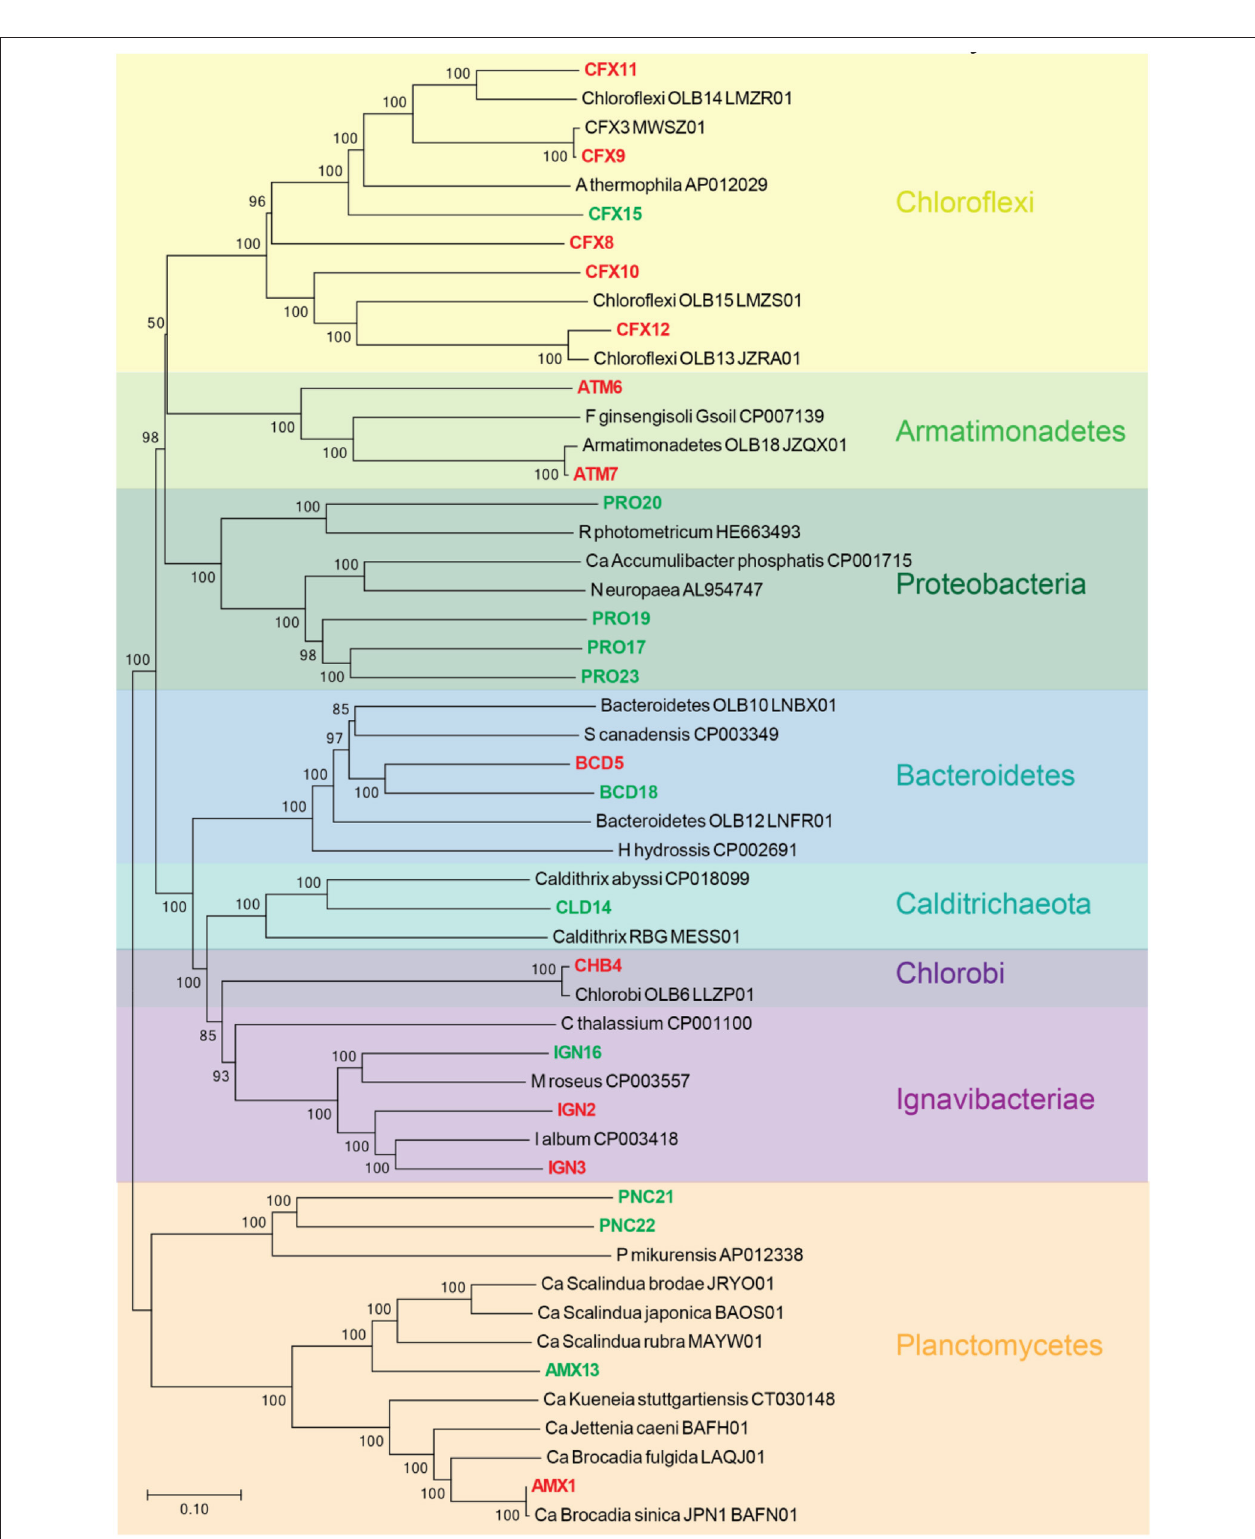
FIGURE 1 | Neighbor-joining phylogenetic tree showing the evolutionary relationship between all recovered metagenome-assembled genomes (MAGs) and the closely related genomes downloaded from the NCBI genome repository. The closely related genomes were identified using Genome Taxonomy Database (GTDB) as described elsewhere (Chaumeil et al., 2020). Tree includes MAGs recovered from freshwater (red) and marine water (green) reactor. GenBank accession numbers for each genome are provided. Branch node numbers represent bootstrap support values and the bootstrap consensus inferred from 1,000 iterations.